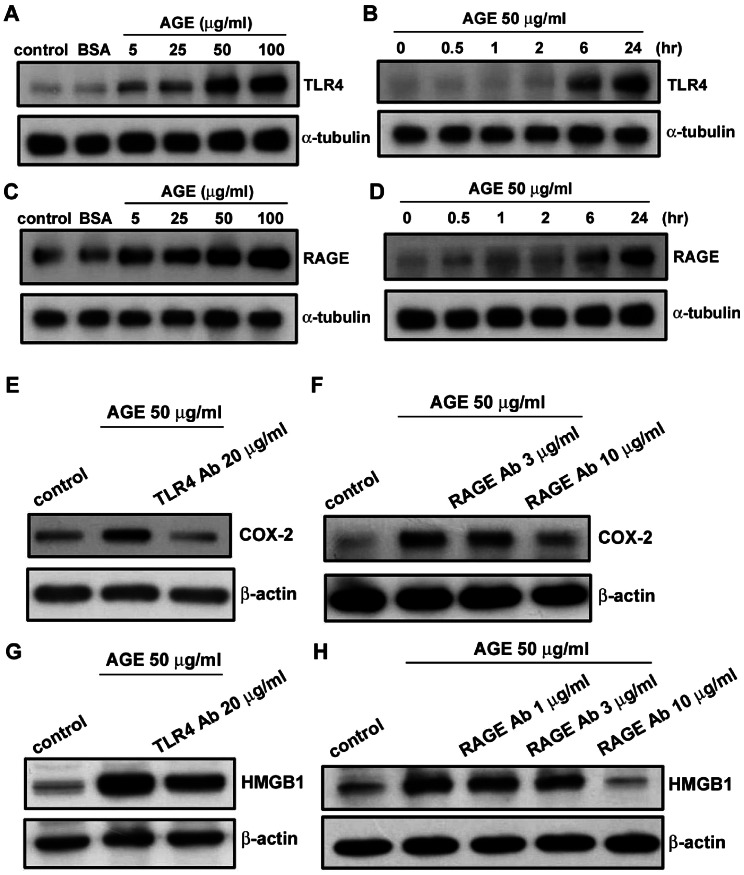
Involvement of TLR4 and RAGE in AGEs-induced COX-2 and HMGB1 protein expressions in human OA chondrocytes.In A-D, human OA chondrocytes (1×106/ml) were treated with AGEs (5–100 µg/ml) for 24 hours (A, C) or 0.5–24 hours (B, D). Protein expressions of TLR4 (A, B) and RAGE (C, D) were measured by Western blotting. In E–H, human OA chondrocytes (1×106/ml) were pretreated with neutralizing antibodies of TLR4 (20 µg/ml) and RAGE (10 µg/ml) for 1 hour followed by treatment with AGEs (50 µg/ml) for 24 hours. Protein expressions of COX-2 (E, F) and HMGB1 (G, H) were determined by Western blotting. Results shown are representative of at least three independent experiments.